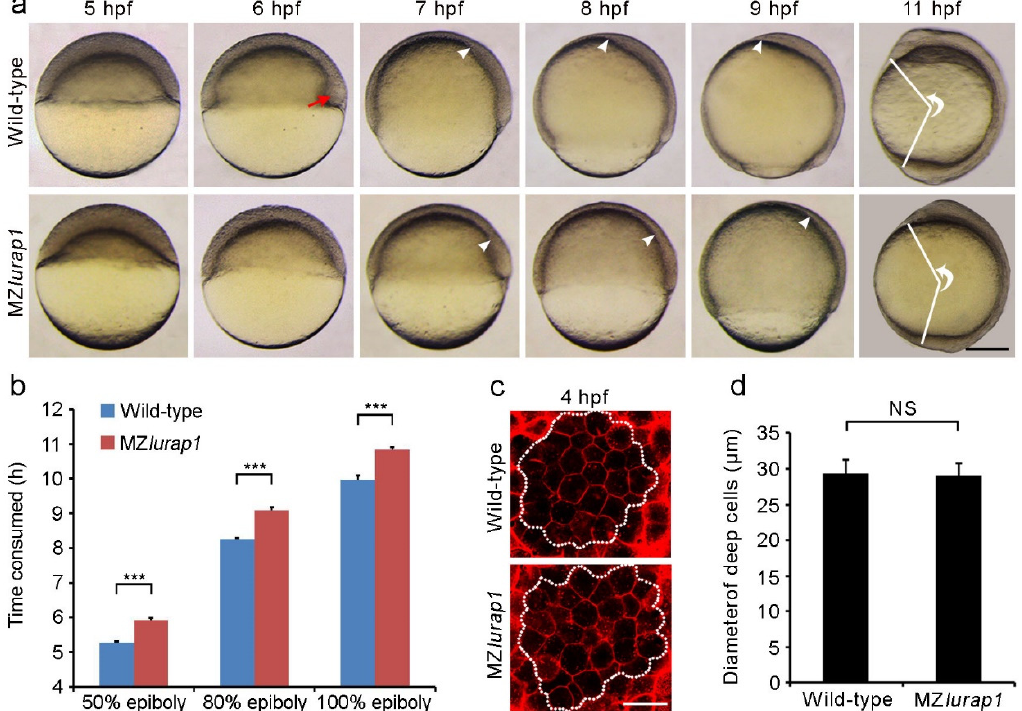
Figure 1. Delayed epiboly movement and reduced anteroposterior axis elongation in MZ lurap1 mutant embryos. ( a ) Live images show epiboly progression in time-matched wild-type and MZ lurap1 mutant embryos. Lateral view with animal pole or anterior region on the top. The red arrow indicates the embryonic shield; white arrowheads indicate the front of collective migration of prechordal mesendoderm. The extent of anteroposterior axis elongation is reflected by the angle formed between the most anterior end and the most posterior end, with vertex at the geometric centre of the embryo. Scale bar: 200 µ m. ( b ) Comparison of the time interval to reach indicated epiboly stages between wild-type and MZ lurap1 mutant embryos. Data were collected from three independent crosses, using a total of 150 embryos for each group. Bars represent the mean value ± s.d. (***, p < 0.001). ( c ) Examination of deep cell size at the animal pole region (dashed circles) in wild-type and MZ lurap1 mutant embryos at 4 hpf. Scale bar: 50 µ m. ( d ) Measurement of cell diameters by assuming that all cells are spherical. For each condition, data were obtained using 10 embryos from three independent crosses. Bars represent the mean value ± s.d. (NS, not